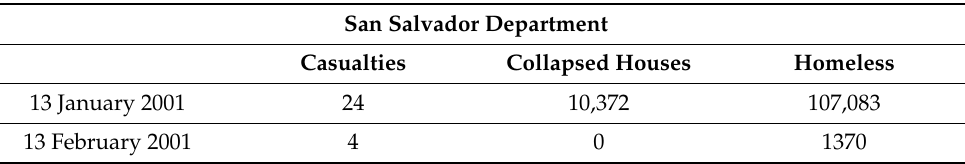
Table 3. Damage after the two main shocks of 13 January and 13 February 2001 observed in San Salvador department (after [44]).